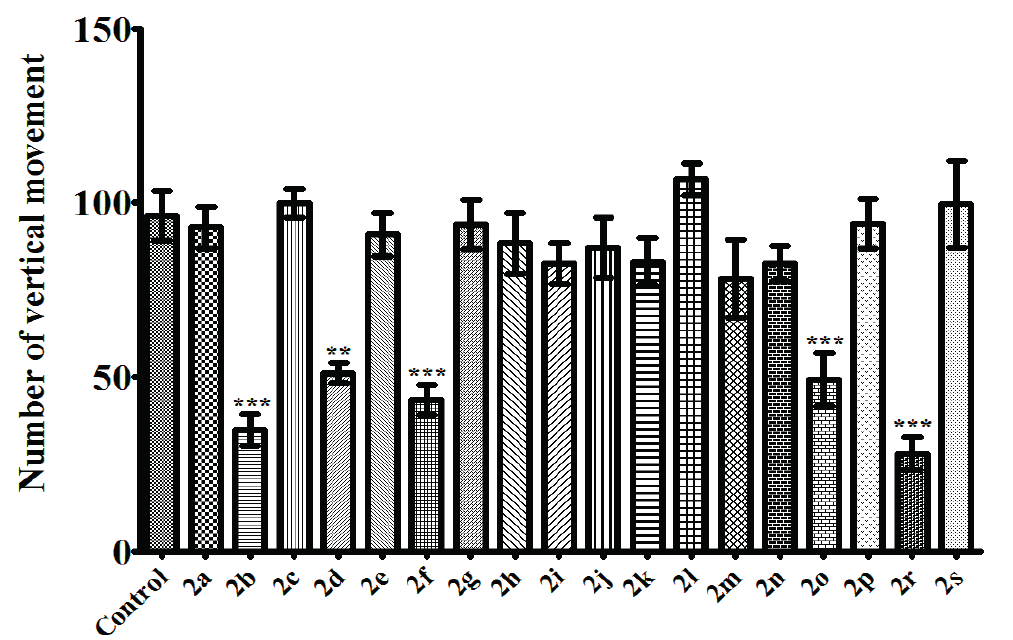
Figure 6. Effects of test compounds (100 mg/kg) on the number of vertical movement of mice in the activity cage test. Significance against control values ** p < 0.01, *** p < 0.001. Values are given as mean ± SEM. One-way ANOVA, post-hoc Tukey’s test, n =